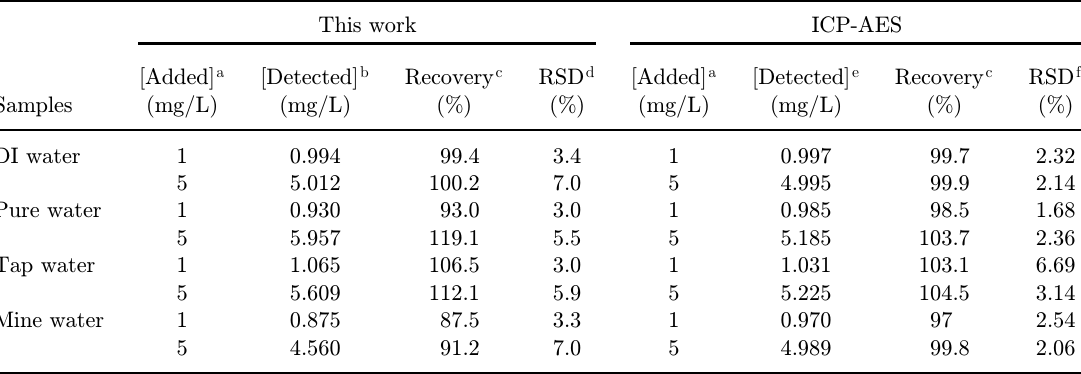
Table 1. Determination of Cr(III) in four water samples by the proposed method and ICP-AES ð n ¼ 3 Þ .